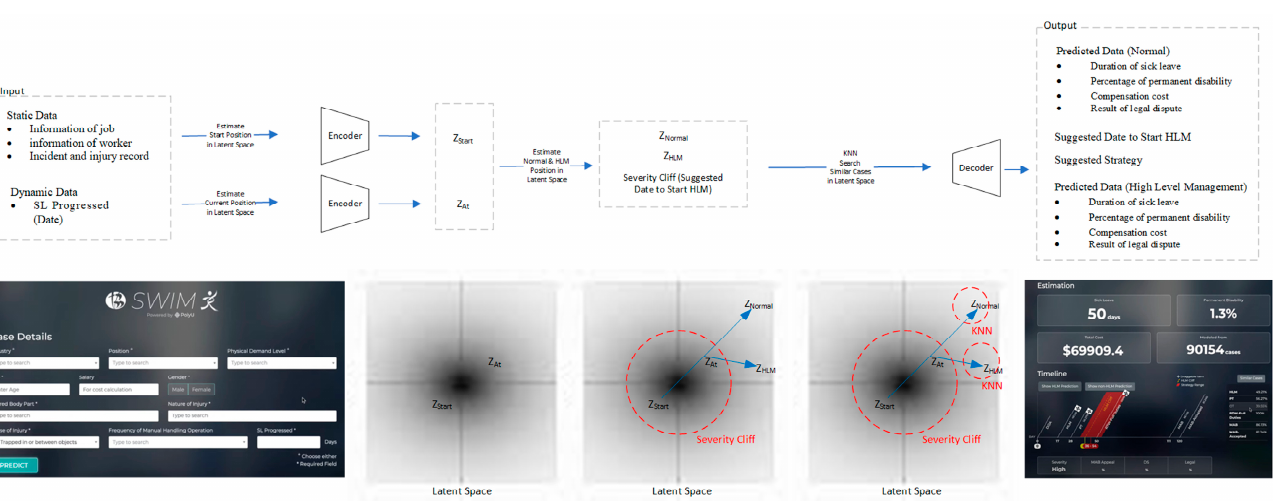
Figure 1. Overview of our current work (SWIM 1.0).